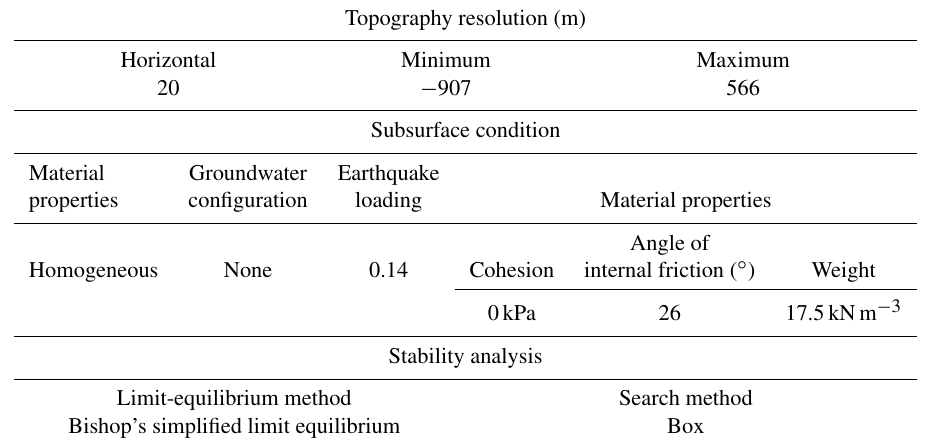
Table 1. Slope stability analysis